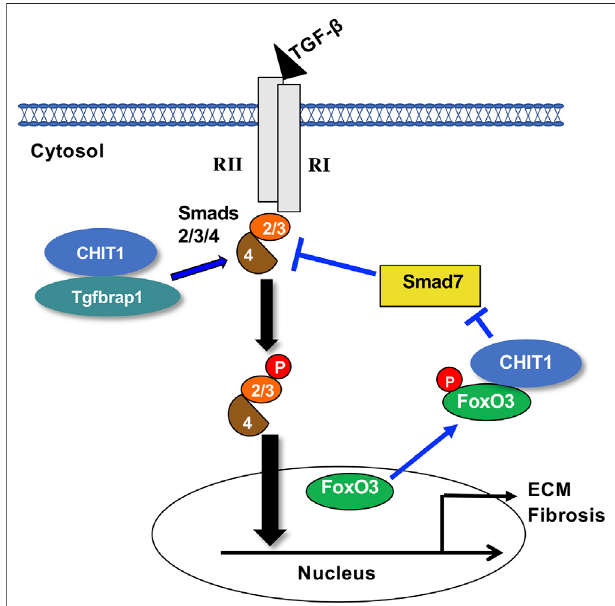
FIGURE 2 | Suggested pathway that chitinase 1 uses to regulate TGF- β signaling. Chitinase 1 (CHIT1) binds with transforming growth factor beta receptor associated protein 1 (Tgfbrap1), enhances the canonical receptor mediated Smads2/3 signaling potentially through recruiting of Co- Smad4. CHIT1 also interacts with transcription factor forkhead box O3 (FoxO3) that reduces the nuclear FoxO3 and that results into decreased the Smad7 expression. RI, TGF- β receptor 1; RII, TGF- β receptor 2; p, phosphorylation; ECM, extracellular matrix proteins.